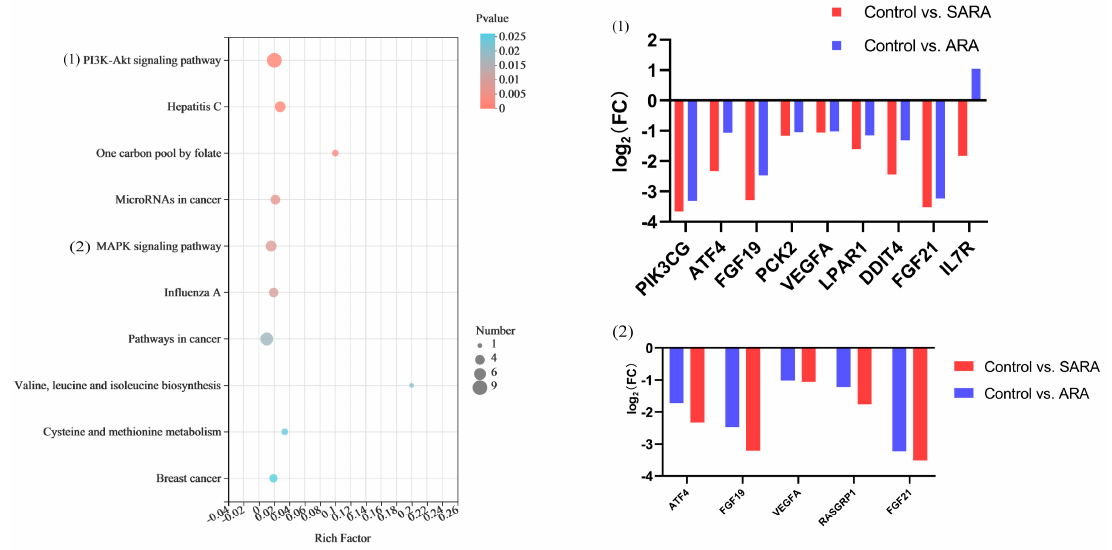
Figure 4. Significant KEGG pathways of 94 shared DEGs in BRECs between “control vs. SARA” and “control vs. ARA”. The significances of the identified KEGG pathways were determined by p < 0.05. Red bars indicate upregulated genes and blue bars indicate downregulated